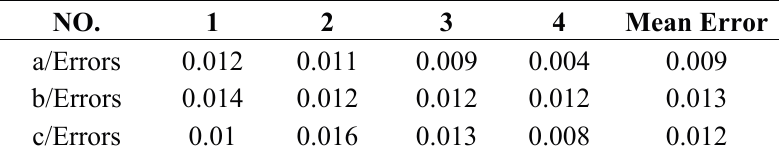
Table 7. Errors for different angles in shaft 1 (mm).